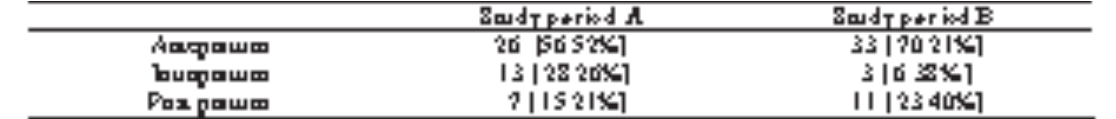
Table IV : Type of eclampsia